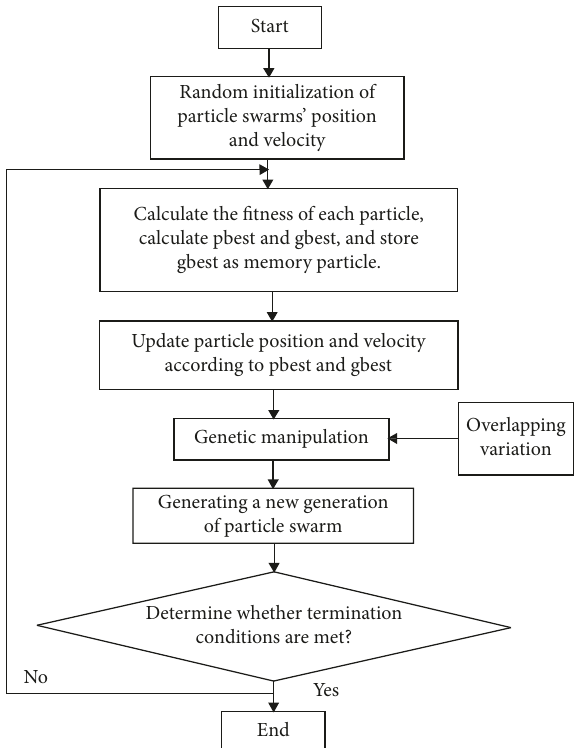
Figure 11: The flow chart of the genetic particle swarm optimization algorithm.